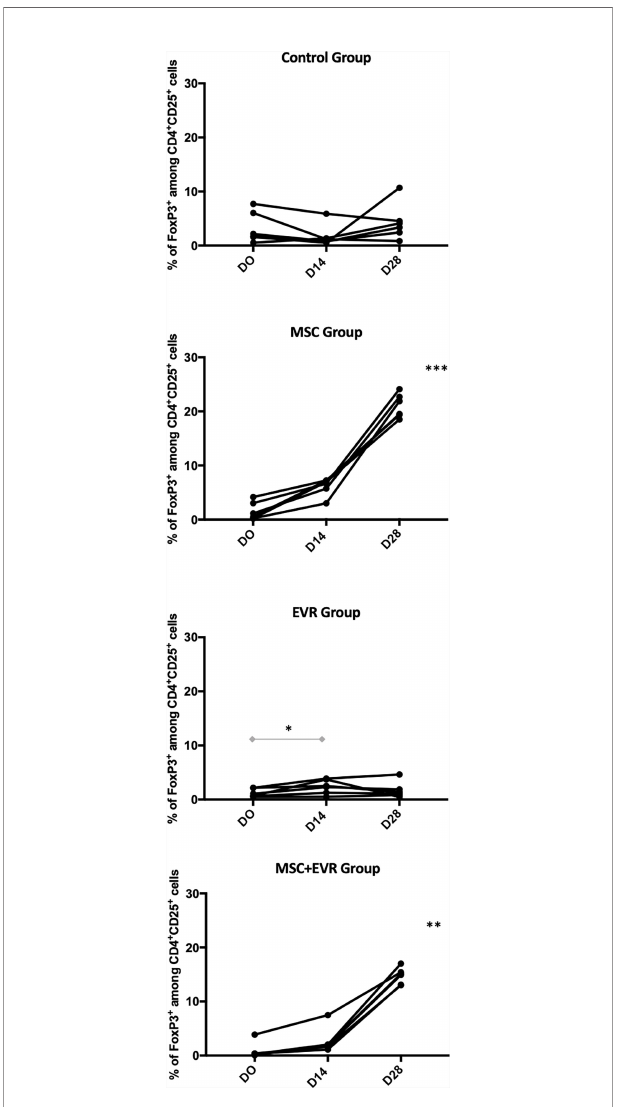
FIGURE 4 | Evolution of CD4 + CD25 + FoxP3 + Treg percentage. Evolution of the FoxP3 + cells among CD4 + CD25 + percentages in each group (each line represents a rat). Rats of the Control group kept a stable percentage of circulating Tregs until D28 (insigni fi cant, NS, P=0.43 ) as well as EVR group ( P=0.052 ). An important and signi fi cant expansion of FoxP3 percentage until D28 was observed in the rats of both the MSC group (***, P = 0.0001) and of the MSC+EVR group (**, P = 0.0017). The Friedman test was used for statistical analysis. Of note, when compared to D0, a slight but signi fi cant increase in the FoxP3+ Tregs percentage was observed in the EVR group at D14 (*, P=0.03, Wilcoxon test ). (D: Day; EVR: Everolimus; MSC: mesenchymal stromal